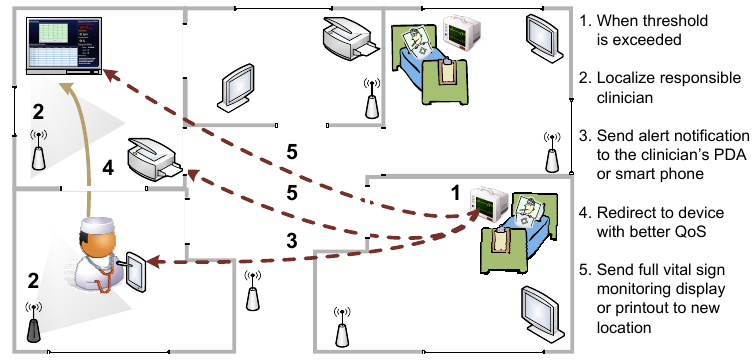
Figure 1. Localization and notification of the responsible physician during an